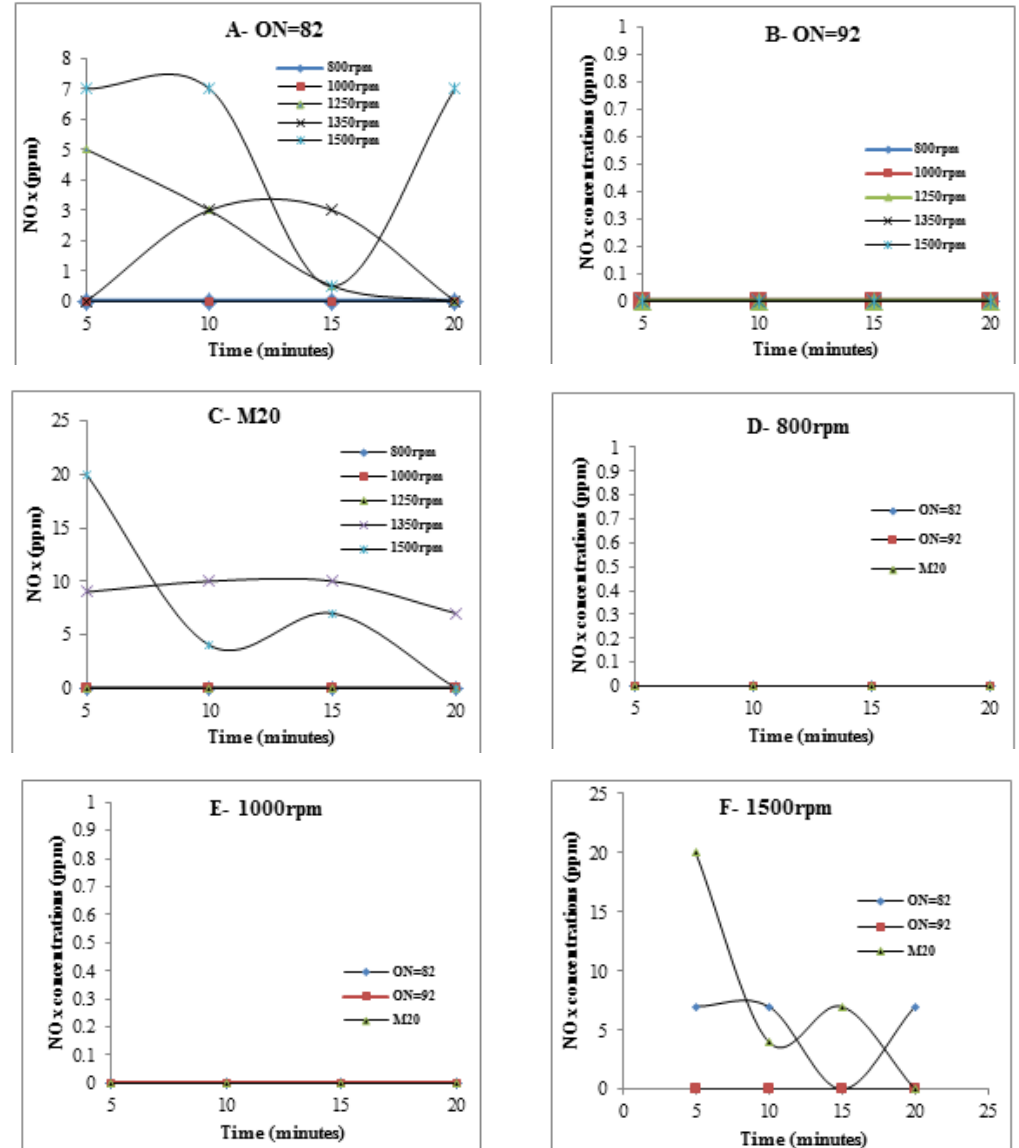
Fig. 7. The idling time effect on emitted NOx for tested fuels at variable engines